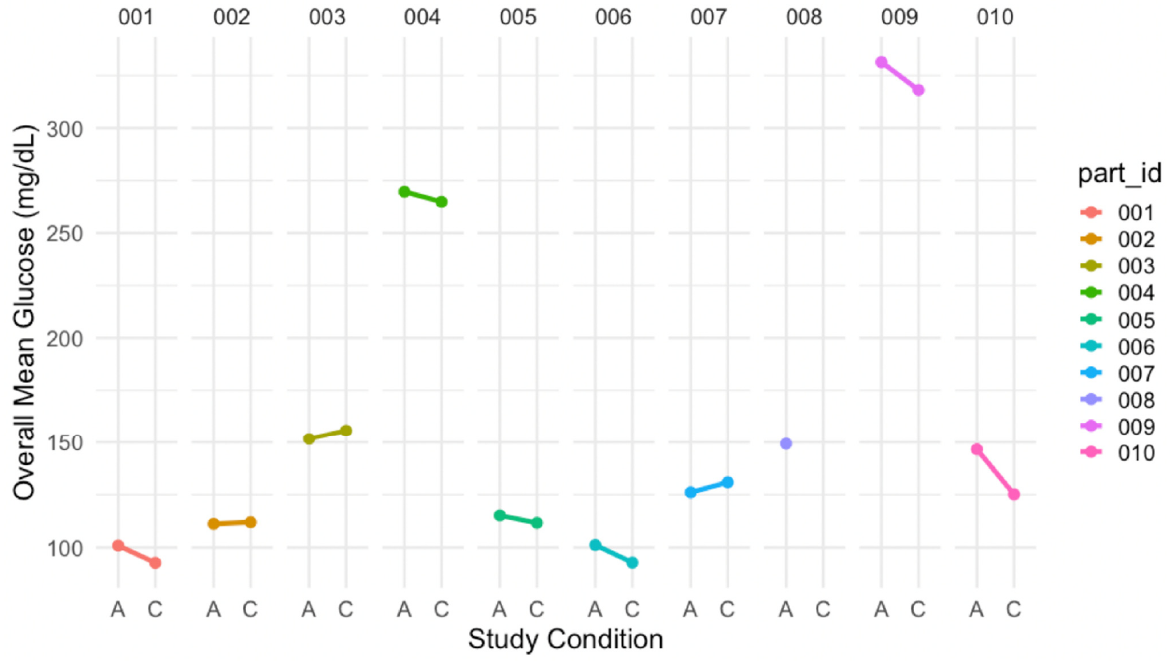
Figure 3. Overall mean glucose (mg/dL) across study conditions, for each participant. Note intercept differences amongst participants.